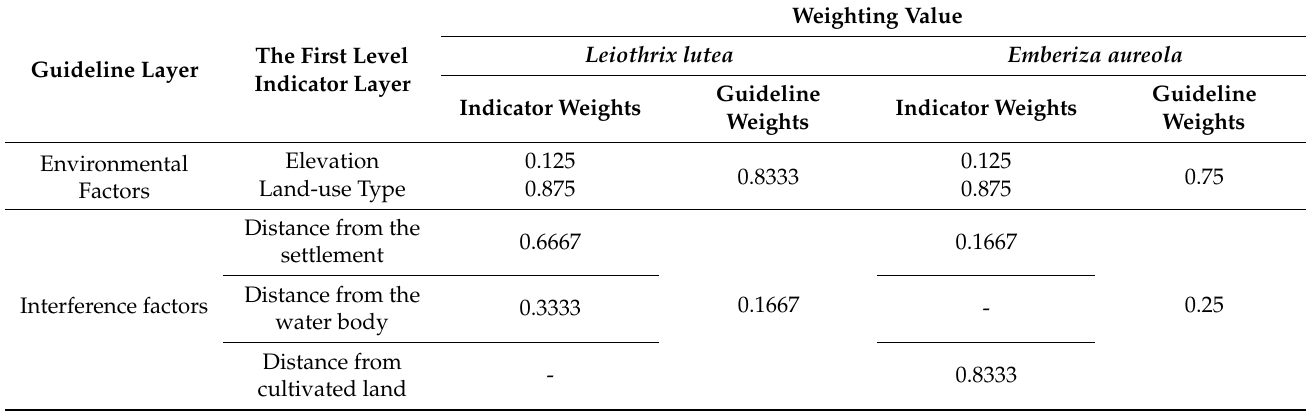
Table 3. Resistance factor weights for indicative